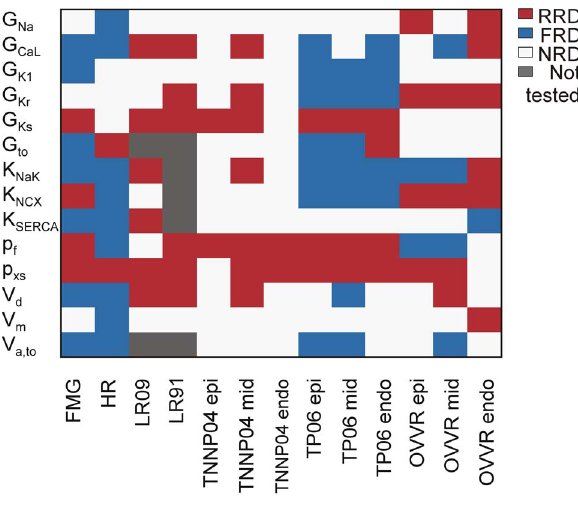
Figure 6. APD parameter sensitivity rate dependence in 13 ventricular myocyte models. For 14 selected parameters that were common to most myocyte models, the heat map shows the rate dependence of these parameters (B RD ) across the various models. B RD $ 0.03 is considered reverse rate dependent ( red ), B RD #2 0.03 forward rate dependent ( blue ), and 2 0.03 , B RD , 0.03 non-rate dependent ( white ). Epi =epicardial, mid =midmyocardial, and endo =endocardial.